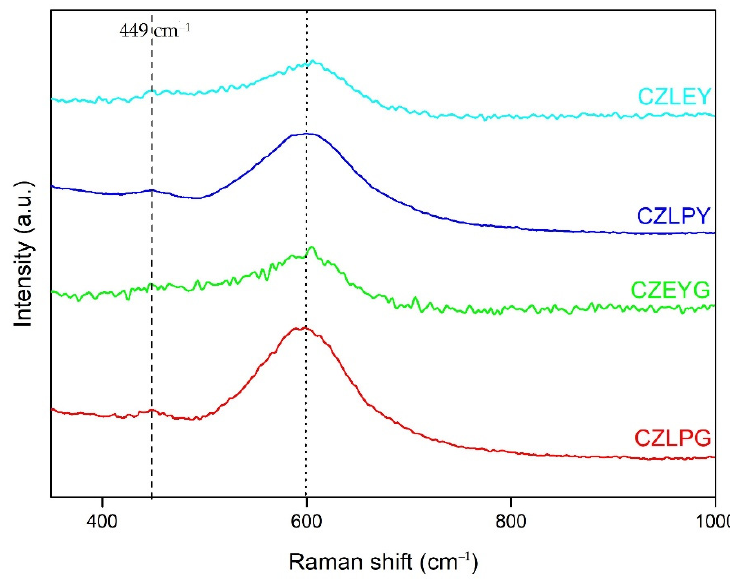
Figure 2. Raman spectra of the synthesized HEOs.